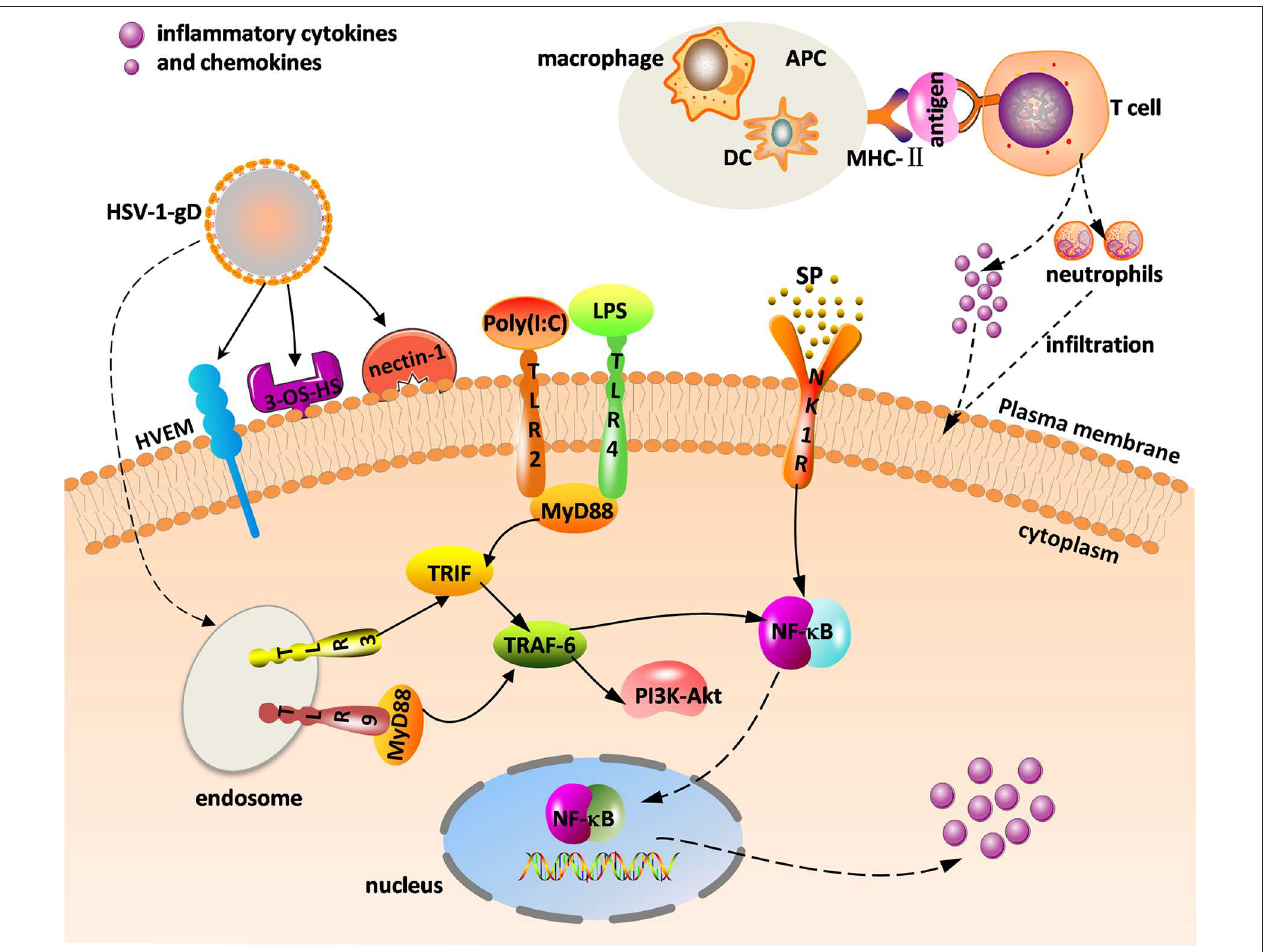
FIGURE 1 | Innate and adaptive immune response in herpes stromal keratitis (HSK) in response to herpes simplex virus (HSV-1) infection. The combination of gD and its receptors [e.g., herpesvirus entry mediator (HVEM), 3-OS-HS, and nectin-1] facilitates virus fusion. HSV-1 and virus analogs [e.g., ploy(I:C), LPS] bind to Toll-like receptors (TLRs) to promote intracellular signaling. Major histocompatibility complex II (MHC-II) transmits the antigenic information on the surface of antigen-presenting cells (APCs) [e.g., dendritic cells (DC), macrophage] to T cells, and activated T cells promote the release of inflammatory factors and neutrophils. The combination of substance P (SP) and the neurokinin-1 receptor (NK1R) activates nuclear factor κ B (NF- κ B) to increase inflammatory cytokine and chemokine